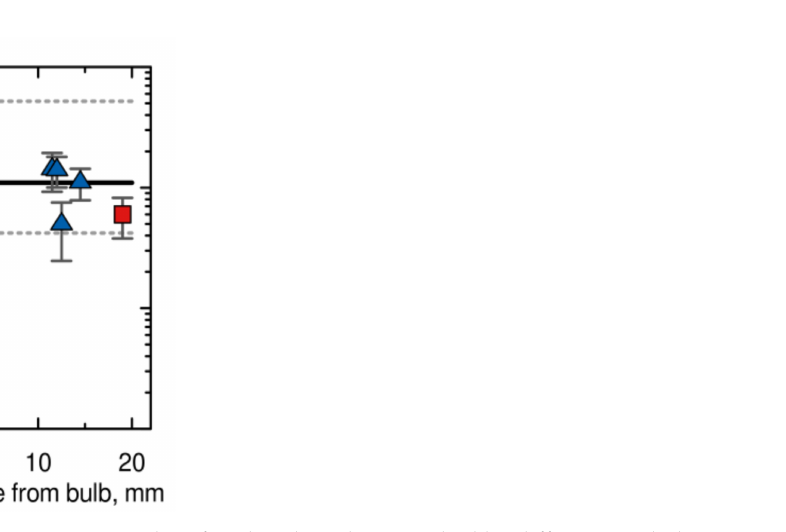
Figure 7. Pb content in two samples of Brahe’s hair distinguished by different symbols, 10 mm of hair represents approximately 1 month of life (modified from [37]).